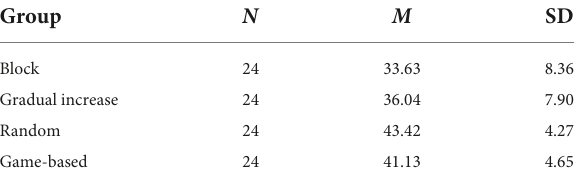
TABLE 4 Means and standard deviations of game transfer test for each group. Group